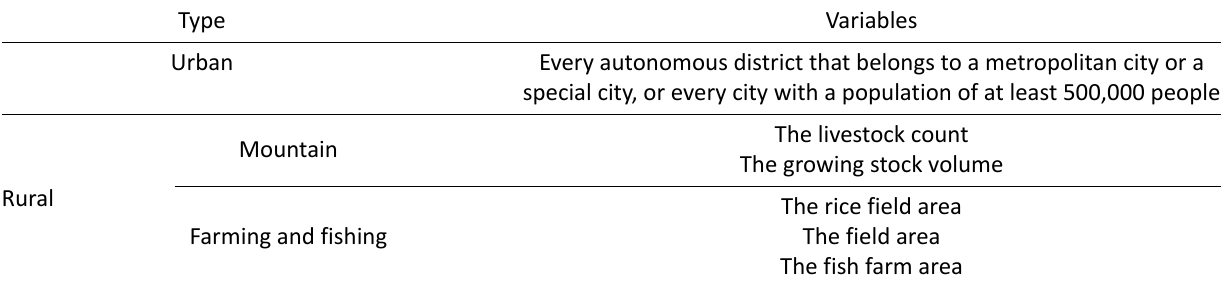
Table 1. Selection of variables for the classification of municipalities.